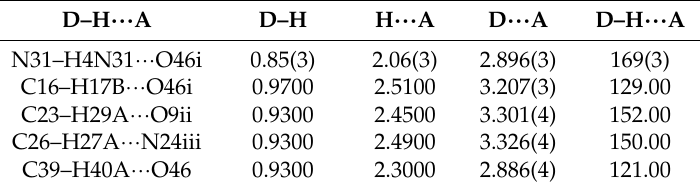
Table 3. Hydrogen-bond geometry (Å) of the semicarbazone 4